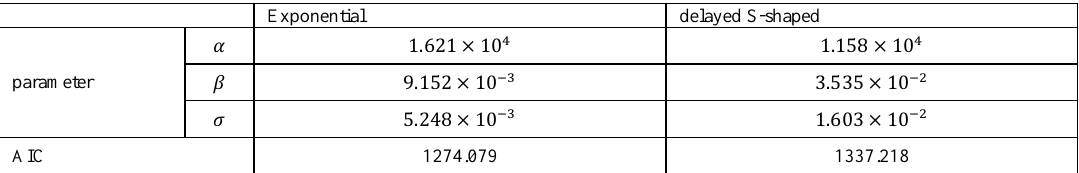
Table 1. Parameter estimation in